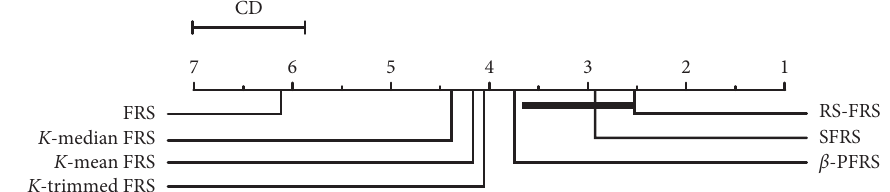
Figure 6: CD diagram of different FRS models on LSVM based on Bonferroni-Dunn statistical